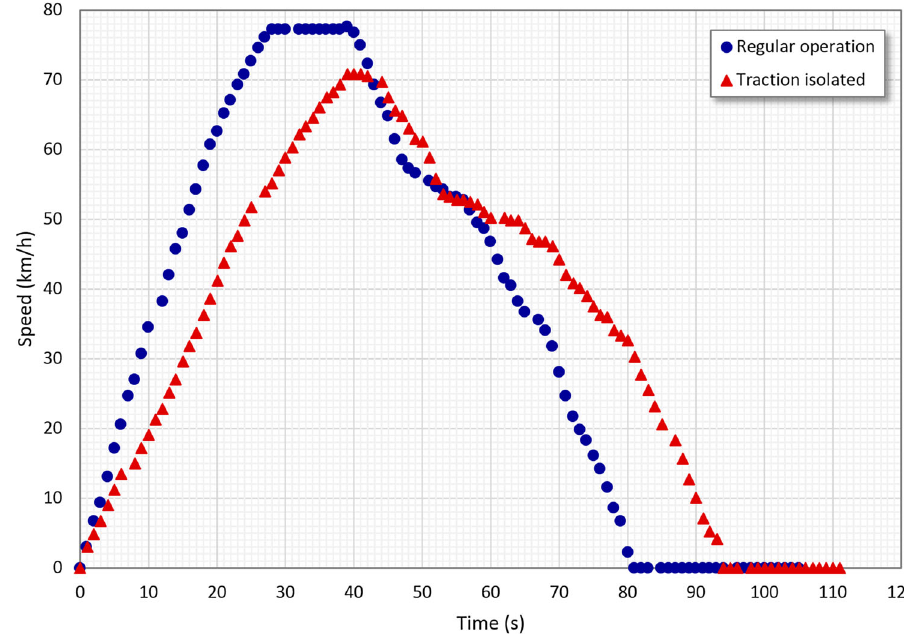
Fig. 4 Comparison of speed profiles for normal operation and reduced tractive effort